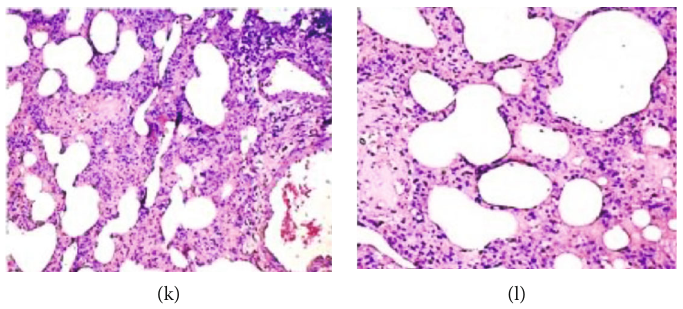
Figure 3: Histological changes in lung tissue after ARDS modeling and treatment. (a) LPS and the (b) LPS+dexamethasone groups. Structural lung damage, edema, alveolar hemorrhage, and (e) in fl ammatory cell in fi ltration. H&E staining × 200. Observation period 48 hours; (c) LPS+HPMSC and (d) HPMSC groups. The mild edema and in fi ltration of the lung tissue with in fl ammatory cells. Observation period 48 hours. H&E staining × 200; (f) LPS and the LPS+dexamethasone groups. Neutrophils (red arrows), (g) giant cells (green arrows), and (h) a large number of alveolar macrophages were noted in the alveolar space. Observation period 96 hours. H&E staining × 800; (i) LPS group. Destruction of lung tissue. H&E staining × 200. (j) LPS+dexamethasone group. Thickening of the alveolar septa. H&E staining × 400; (k) LPS+HPMSC group. A slight thickening of the alveolar septum. H&E staining × 200; (l) the HPMSC group. A solid structure, clear alveolar space without congestion in the alveolar wall. H&E staining × 200. Observation period one